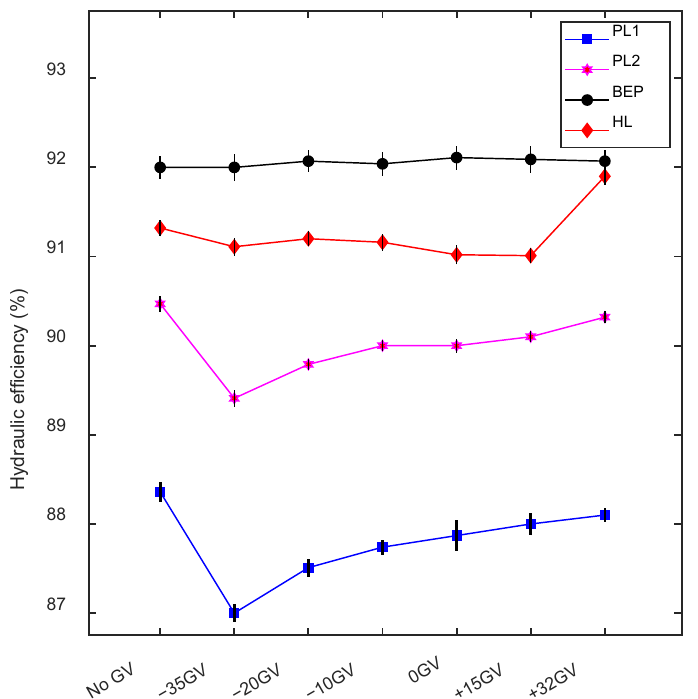
Figure 12. Hydraulic efficiency at all operating conditions without and with the GV systems at different upper hydrofoil angles.